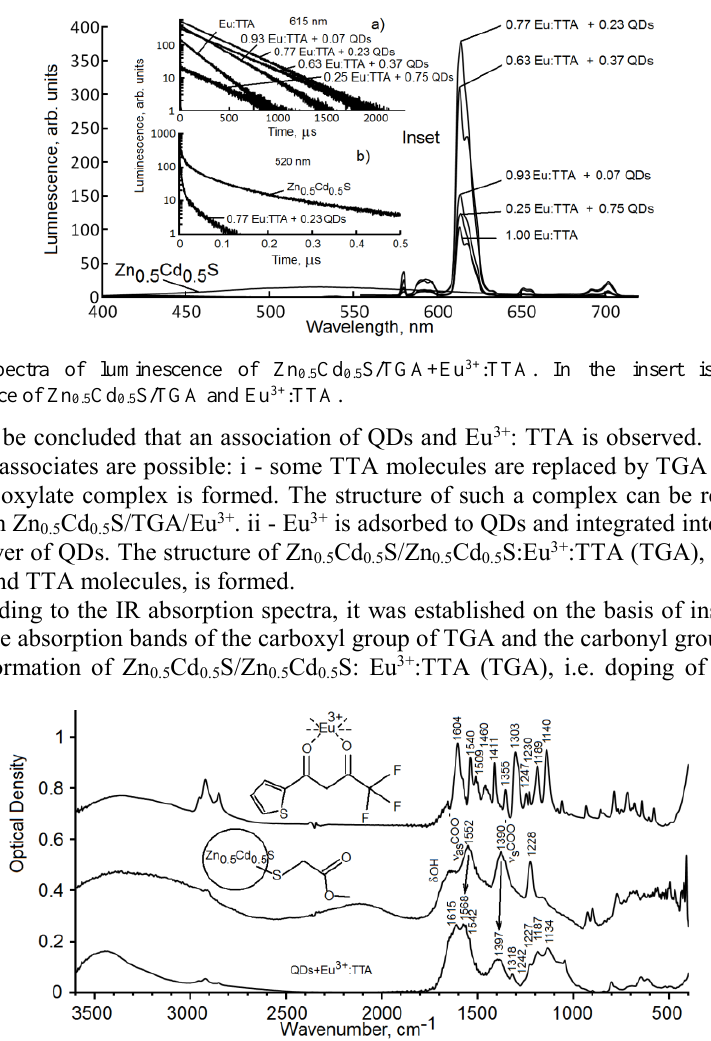
Fig. 2. FTIR spectra and structures of the investigated